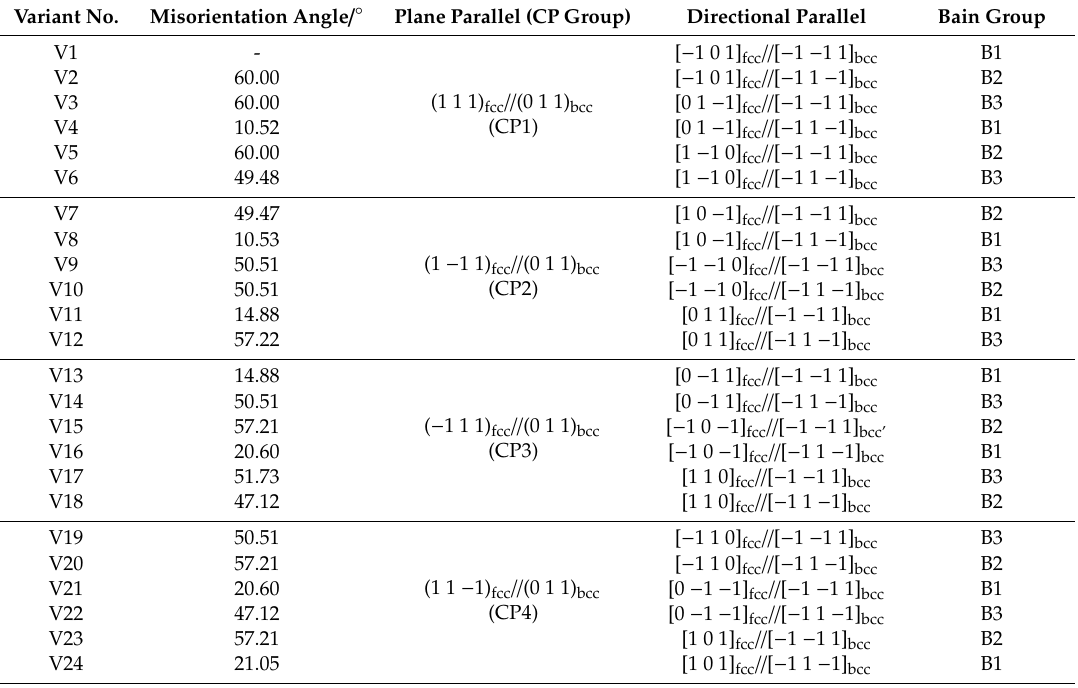
Table 2. Crystallographic parameters of variants for K-S relationship